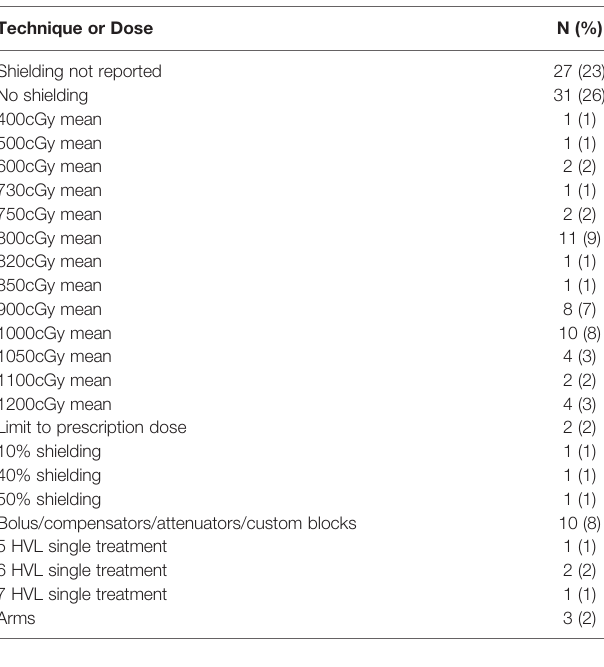
TABLE 4 | Lung shielding.